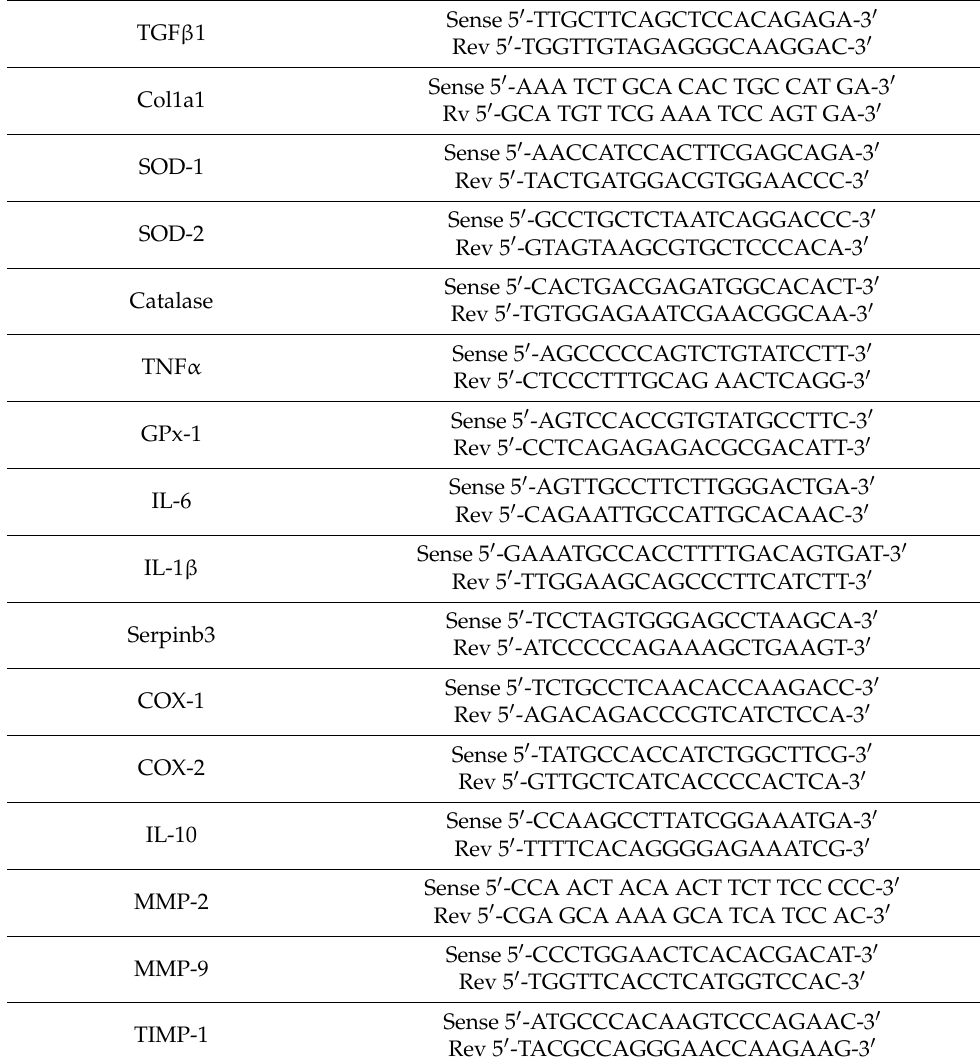
Table 1. List of primers used in mice liver